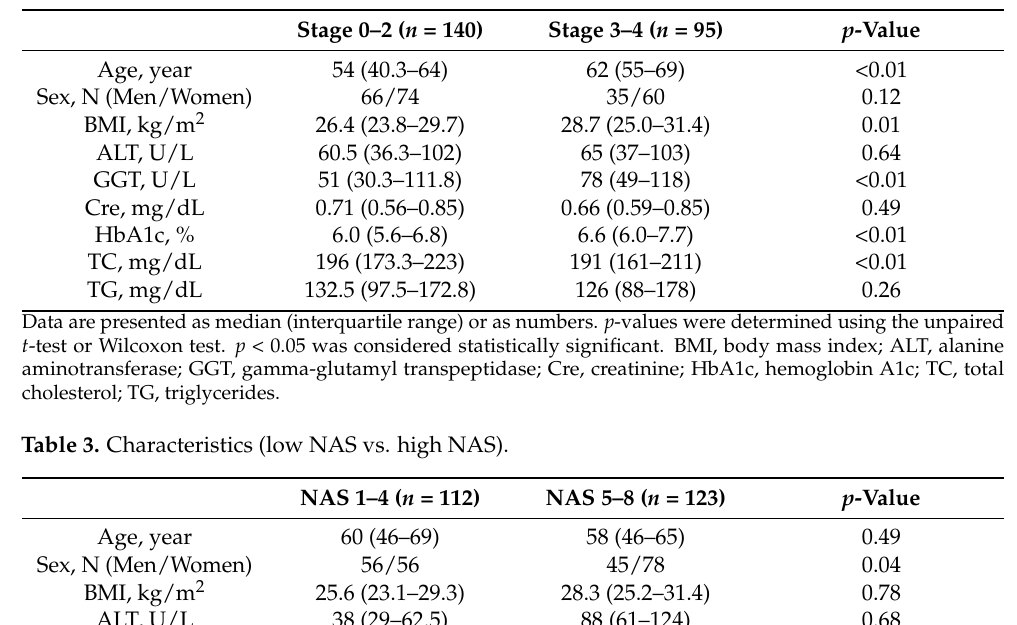
Table 2. Patients’ characteristics (non-advanced fibrosis stage vs. advanced fibrosis stage).